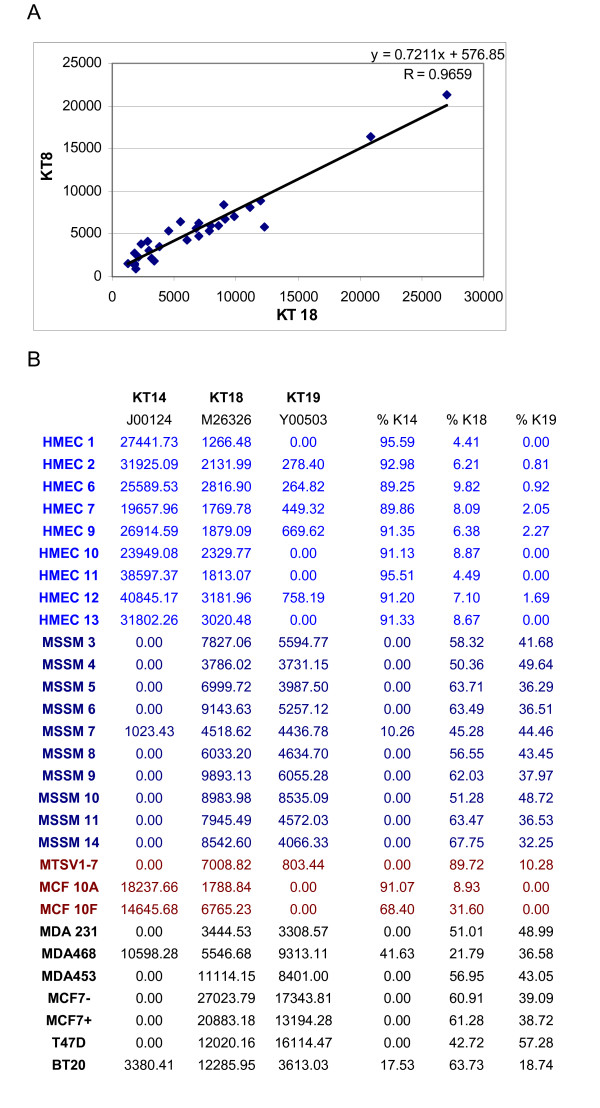
Expression of KT14, KT18 and KT19. a) Plot showsthe correlation of the adjusted intensity (AI) signal of the pair KT8/KT18 for each cell line. b) AI of KT14, KT18 and KT19 of each cell line and its relative percentage.